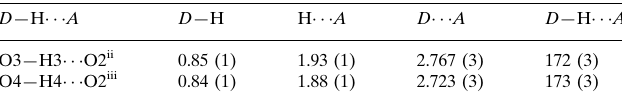
Hydrogen-bond geometry (A˚ , (cid:1)